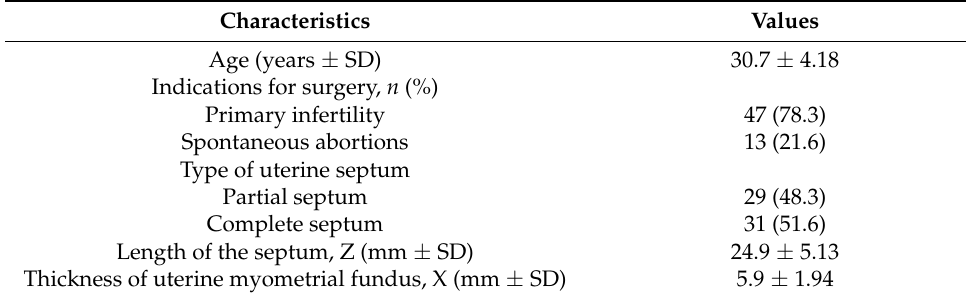
Table 1. Characteristics of women included in the